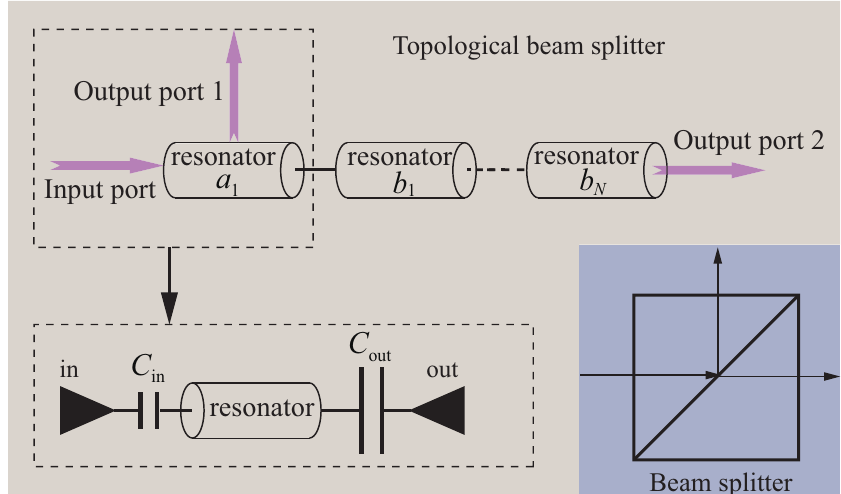
Figure 4. The sketch of the topological beam splitter. According to the property that the input and output processes of each resonator can be individually manipulated, the resonators a 1 and b N can be regarded as one input port and two output ports. The topological beam splitter has three ports, in which the photons coming from the port 1 and finally appear at port 2 and port 3 with a certain proportion. From this perspective, the present system is equivalent to a beam splitter.